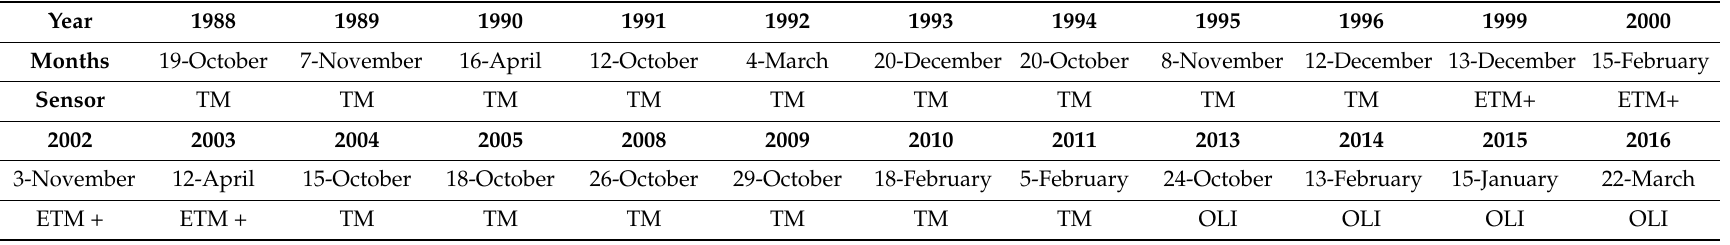
Table 2. Land-cover classification